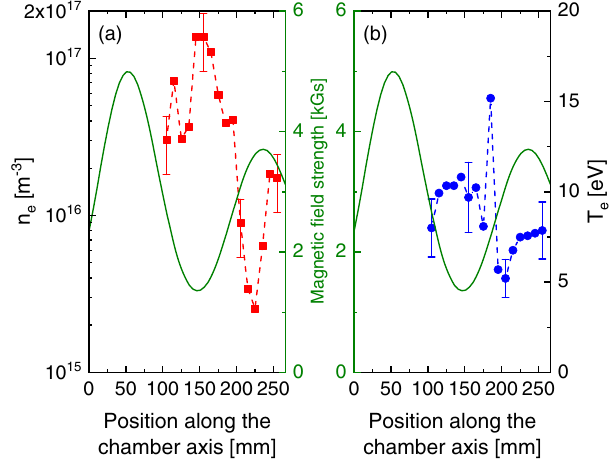
FIG. 7. Electron density (a) and temperature (b) profiles determined from the LP for B 1 . 6 × 10 − 4 mbar and 80 W microwave